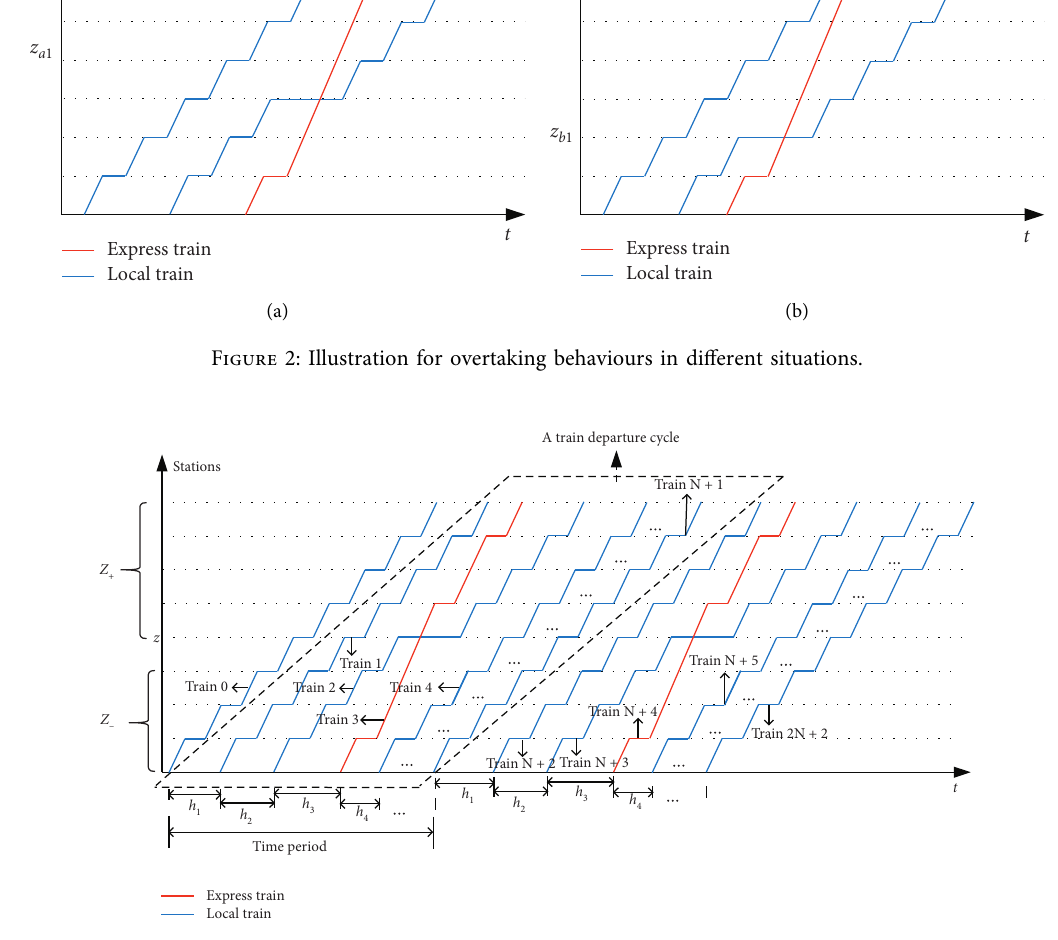
Figure 3: Illustration for train departure cycle in express/local